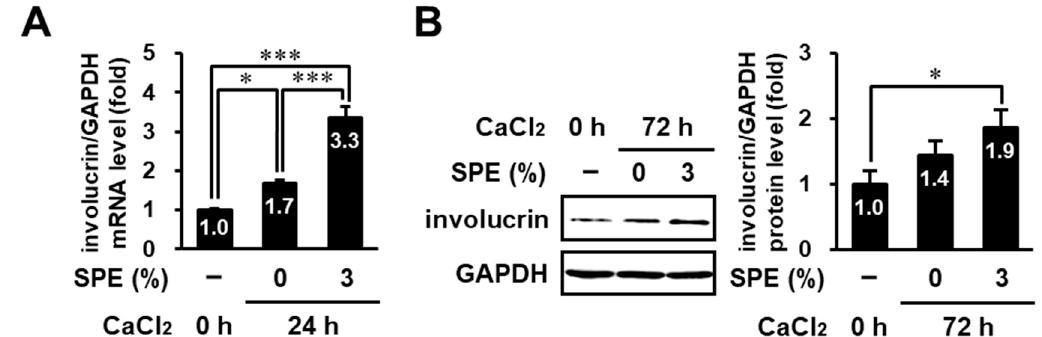
Figure 7. SPE promotes calcium-stimulated differentiation of NHEKs. NHEKs cultured in keratinocyte growth medium 2 including 0.06 mM CaCl 2 were treated with 2 mM CaCl 2 in the presence or absence of 3% SPE for 24 h or 72 h. The cells were subjected to RT-qPCR ( A ) and immunoblot analysis ( B ). The mRNA and protein levels of involucrin were normalized to those of GAPDH. The data are expressed as the mean ± SE derived from at least three independent experiments, and statistical analysis was performed by ANOVA with Bonferroni’s multiple comparisons test; *** p < 0.001, * p < 0.05.